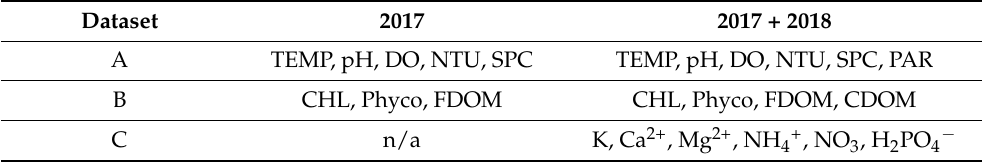
Table 1. Constituents of three input sets used for the random forest analysis.